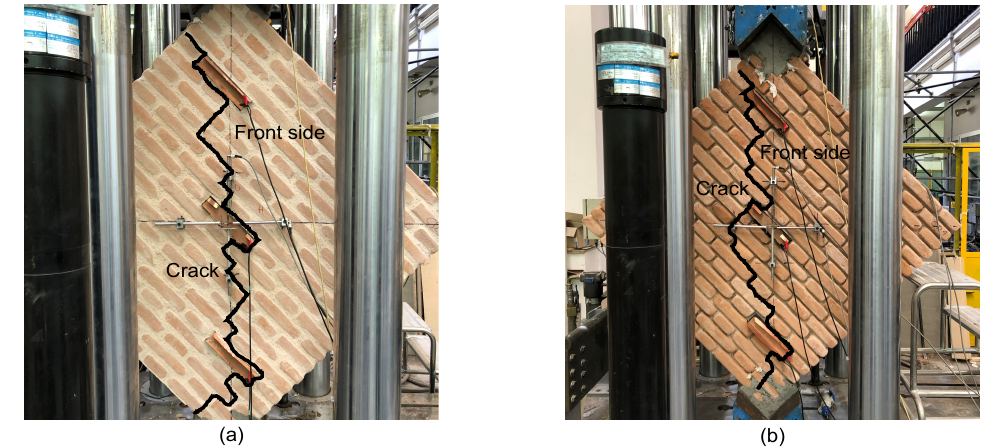
Figure 5. Cracking pattern detected on the tested wall specimens at the end of the tests: ( a ) Specimen A with intact mortar layers; ( b ) Specimen B with degraded mortar